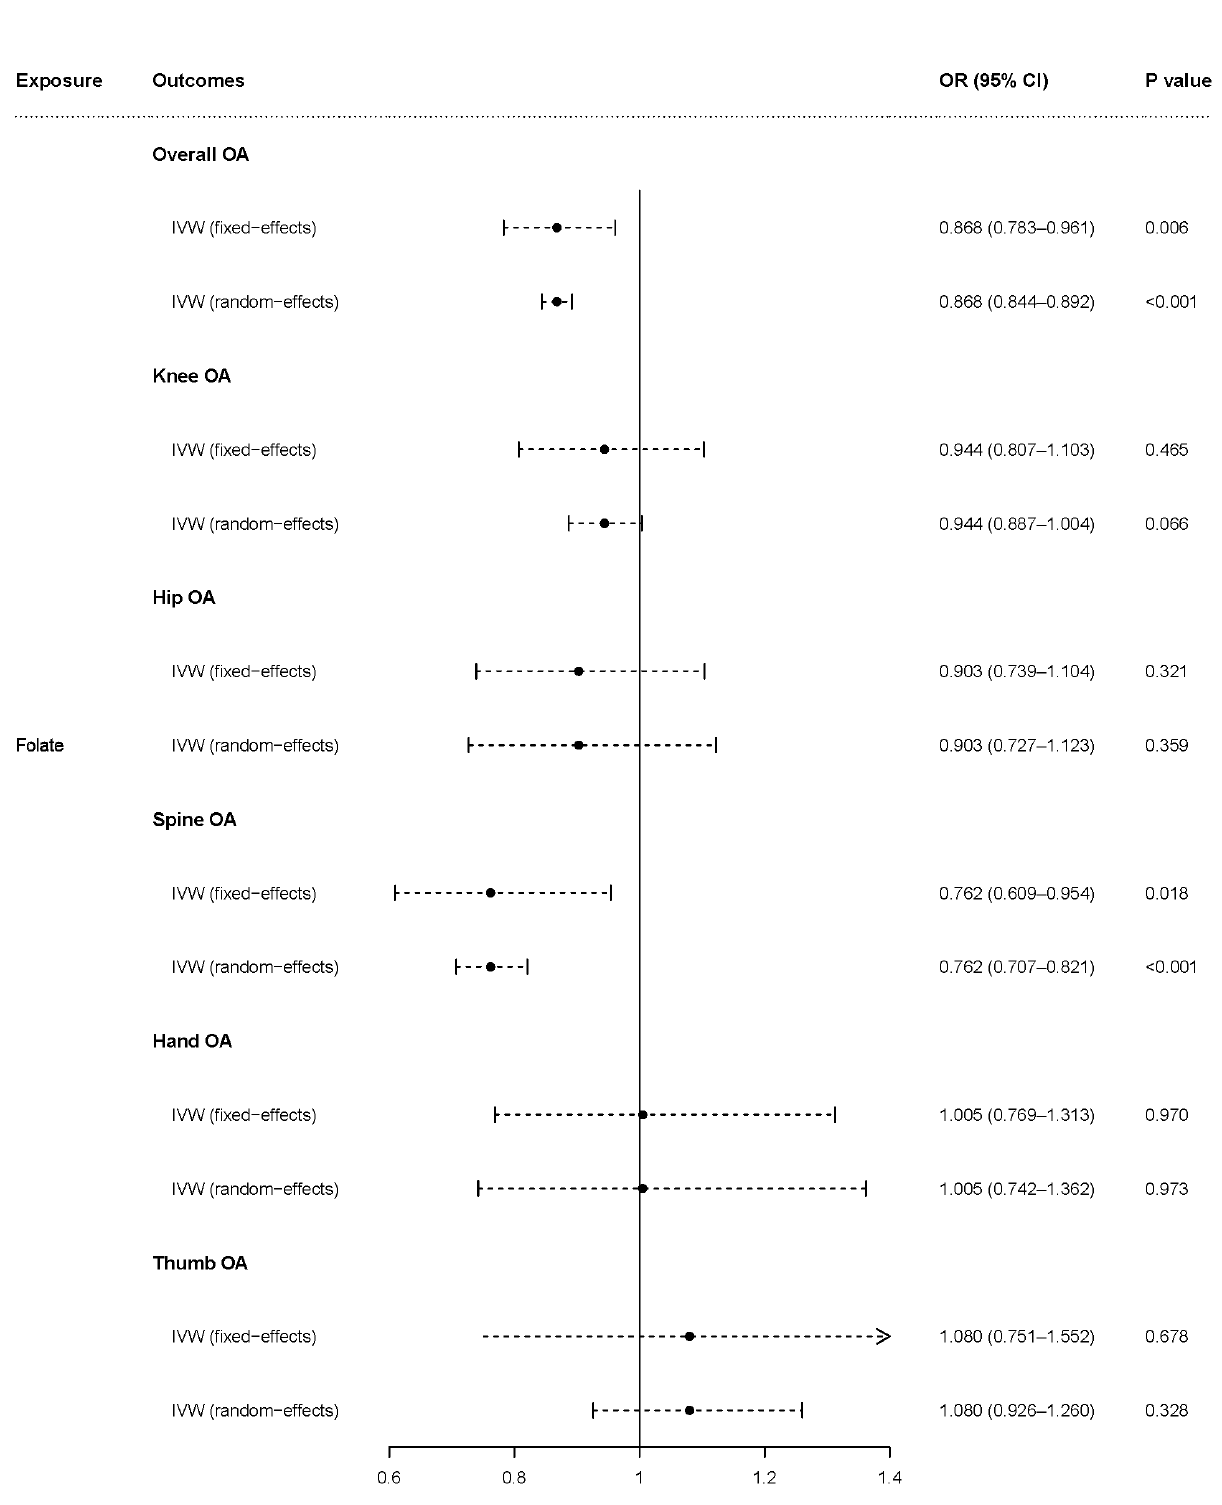
Figure 3. Causal effect of folate on OA and subtypes in fixed-effects and random-effects IVW analyses. OR: odds ratio; CI: confidence interval; p value: p value of the causal estimate.